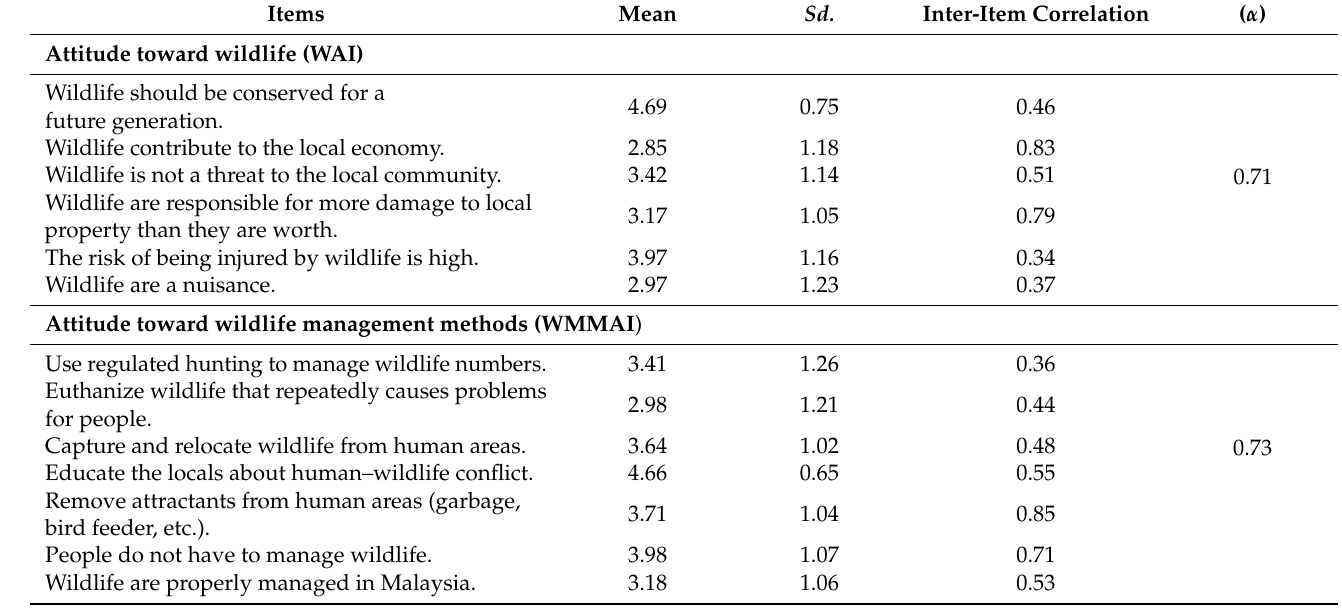
Table 3. Reliability analysis for attitude index of wildlife and their management